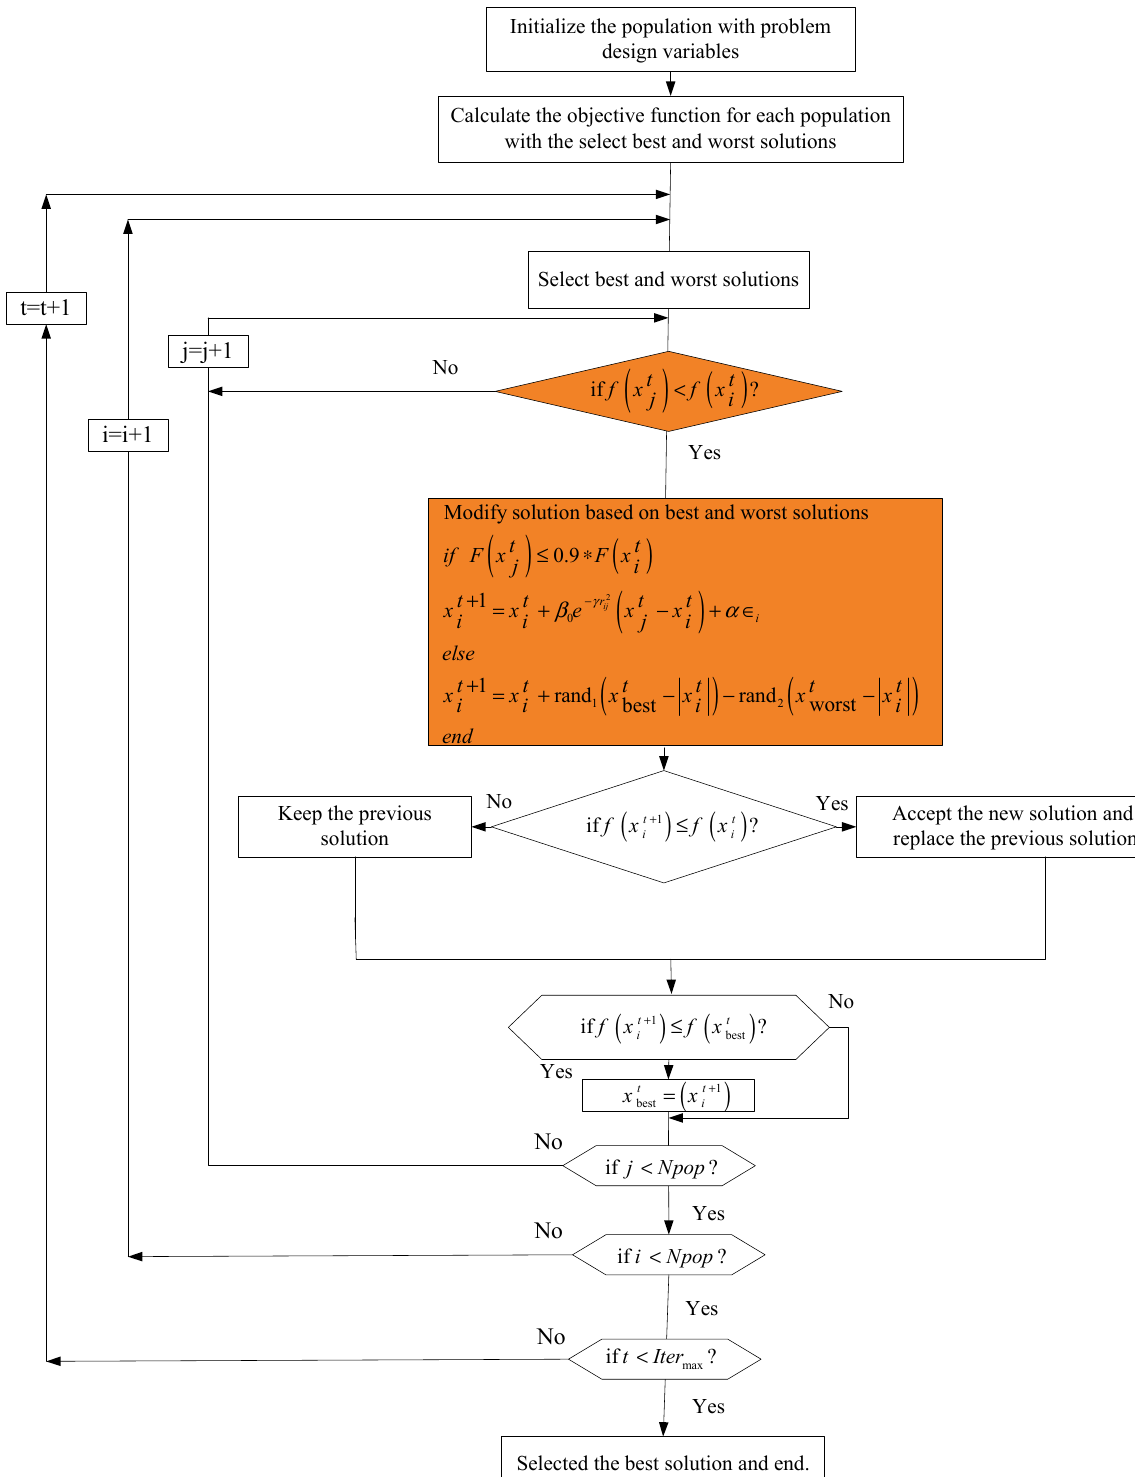
Figure 2. The optimization process of the HFAJAYA optimizer.